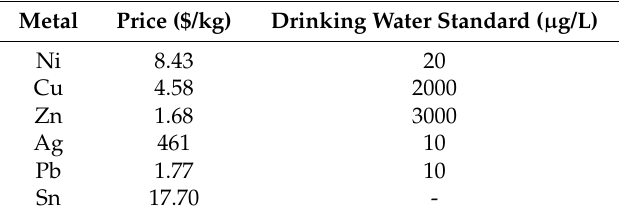
Table 1. Prices and drinking water standards of some heavy metals [9,10].